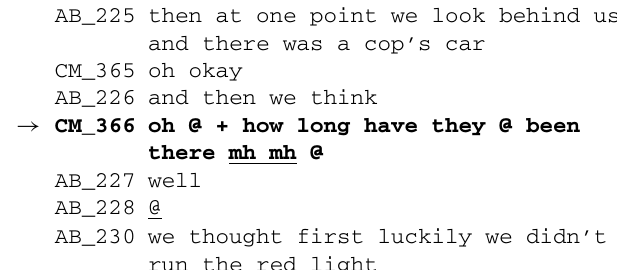
accentual configuration with an expanded span (second occurrence) while the listener (bottom line) is producing the same one but in a very compressed span. The reiteration (by the storyteller) of the same configuration and the prosodic matching (by the listener) both contribute creating a list